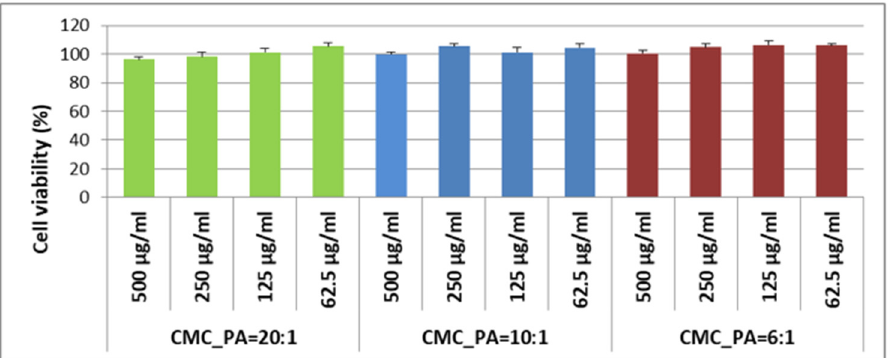
Figure 8. Cell viability of normal human dermal fibroblasts exposed to hydrogel extracts (500/250/125/62, 5 µg/mL) for 24 h; experiments were done in triplicate, and treated cell viability was expressed as percentage of control cells’ viability; graphical data were expressed as means ± standard error of the mean.